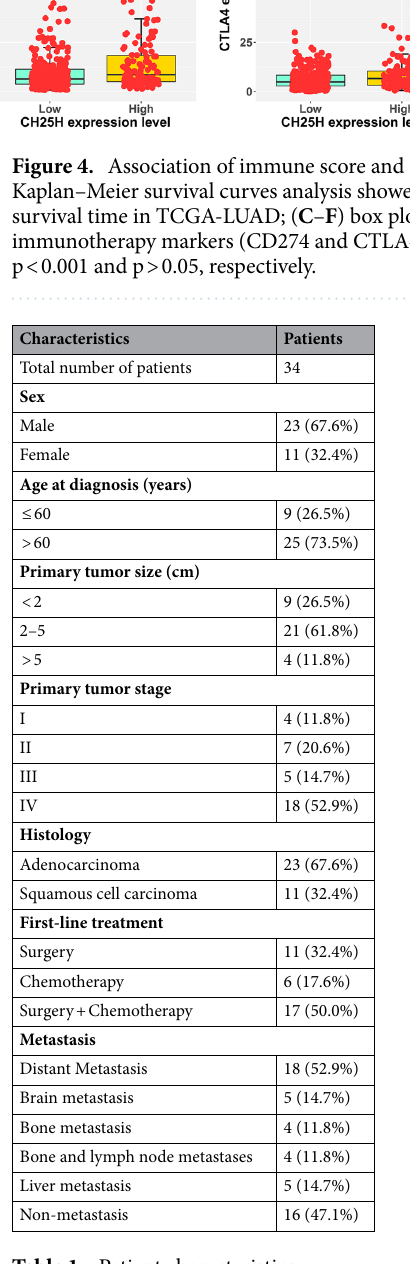
Table 1. Patient